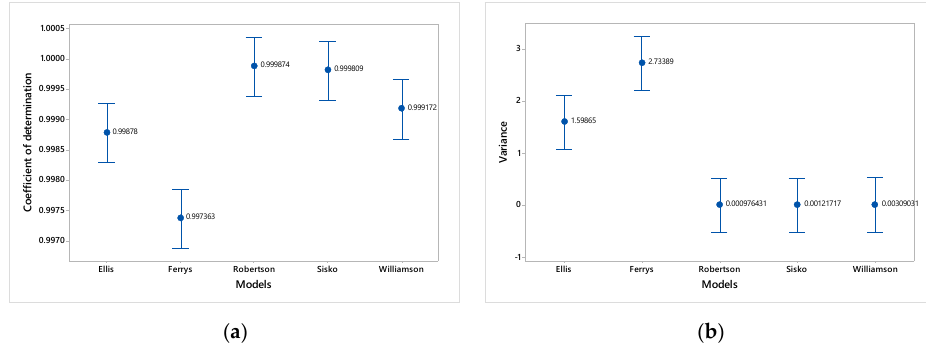
Figure 3. Interval plot for ( a ) the coefficient of determination and ( b ) the variance. 95% confidence interval.